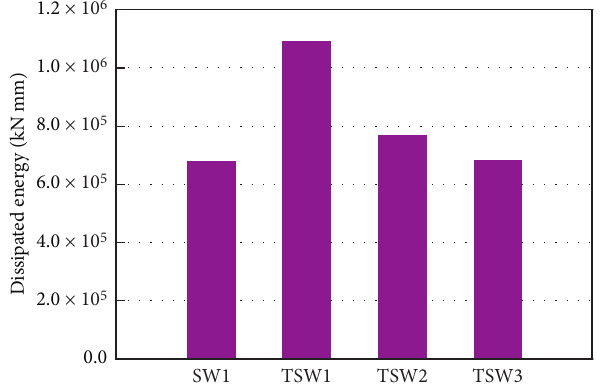
Figure 19: Comparison of total dissipated energies of four